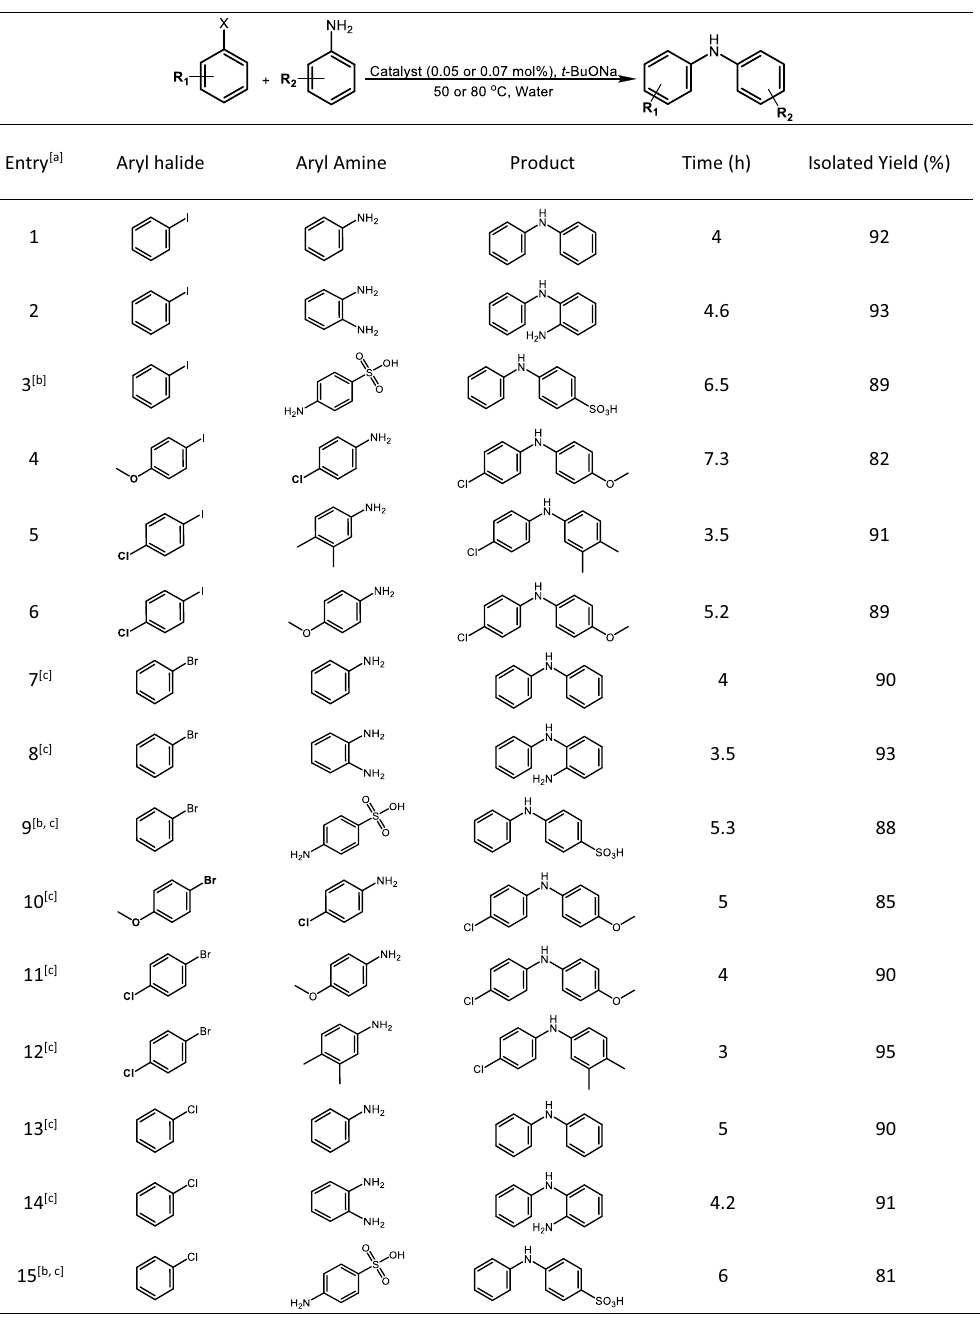
Table 6. Hartwig–Buchwald amination reaction of assorted haloarenes and arylamines catalyzed by γ-Fe 2 O 3 @ MBD/Pd-Co in water. [a] Reaction conditions: aryl halide (1 mmol), arylamines (1.2 mmol), catalyst (0.05 mol% based on the Pd content, except for entries 7–15), and t -BuONa (2 mmol, except for entries 3,9 and 15), 50 °C (except for entries 7–15), The products were characterized by NMR spectroscopy (Figure